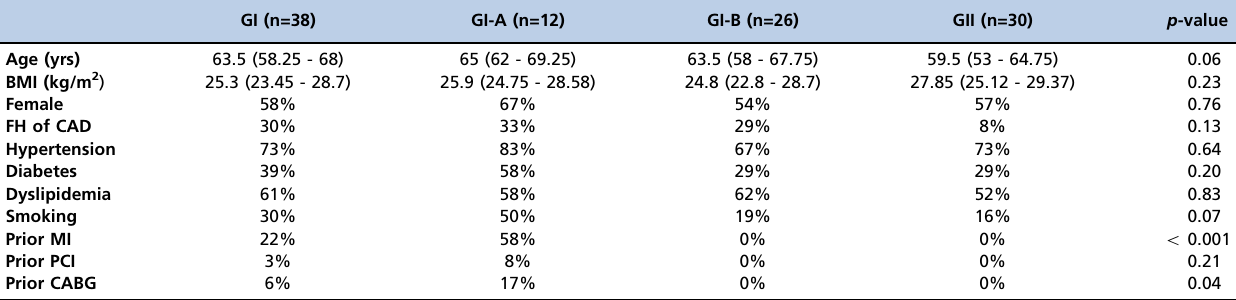
Table 1 - Comparison of demographic characteristics among